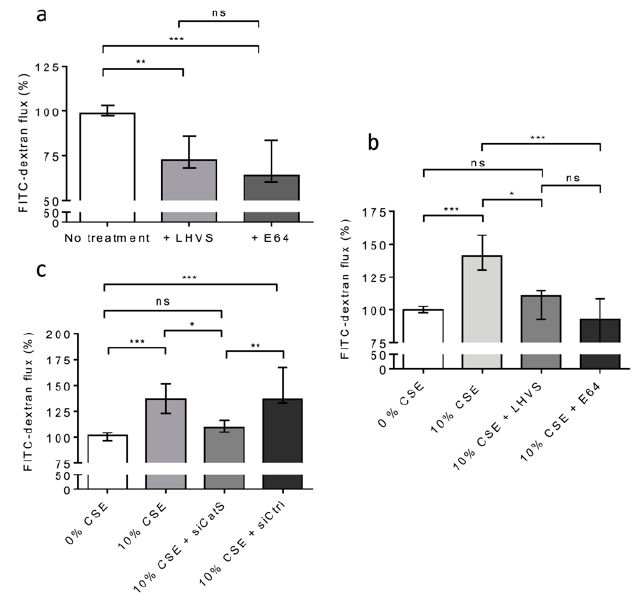
Figure 7. CatS secreted by THP-1 macrophages induced an increase in permeability of lung epithelial cells. ( a ): THP-1 cells (lower culture chamber) were co-cultured with 16HBE cells (seeded on Transwell